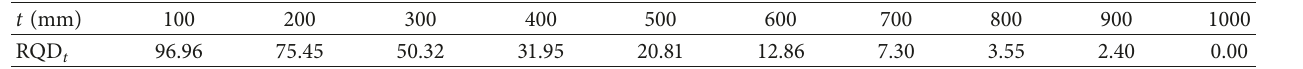
Figure 12: Generalised RQD values (in different directions) with various thresholds of the dam rock mass. Table 10: Average generalised RQD values with different thresholds of the dam rock